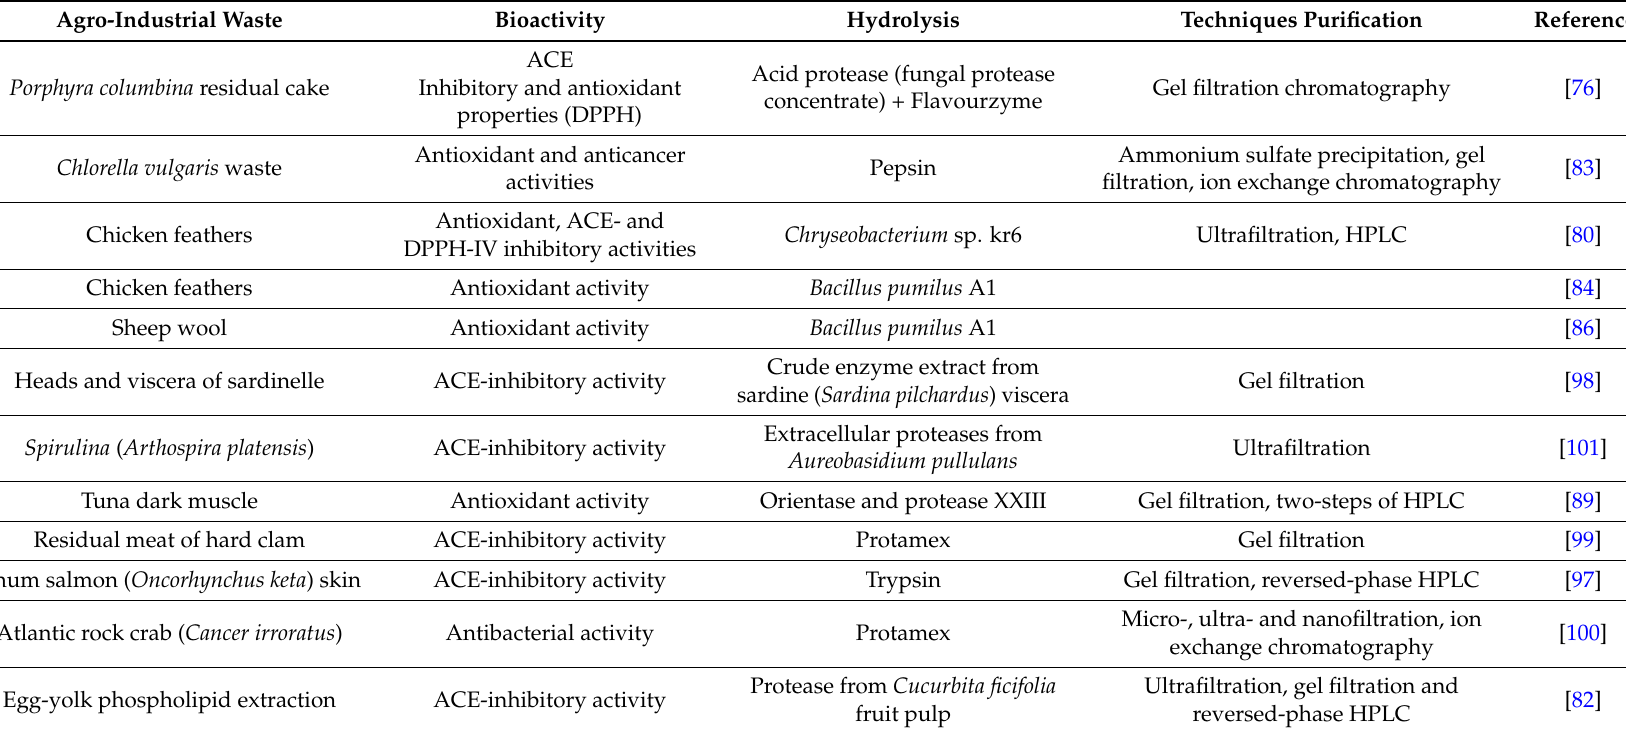
Table 2. Peptides from agro-industrial waste by enzymatic hydrolyses with their respective bioactivity and purification